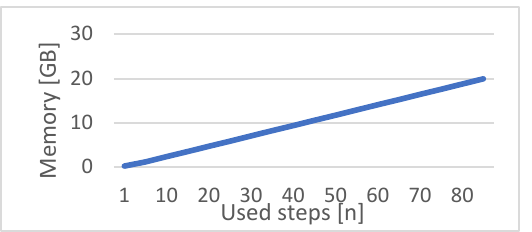
Figure 7. Theoretically needed memory for training with different numbers of used steps.